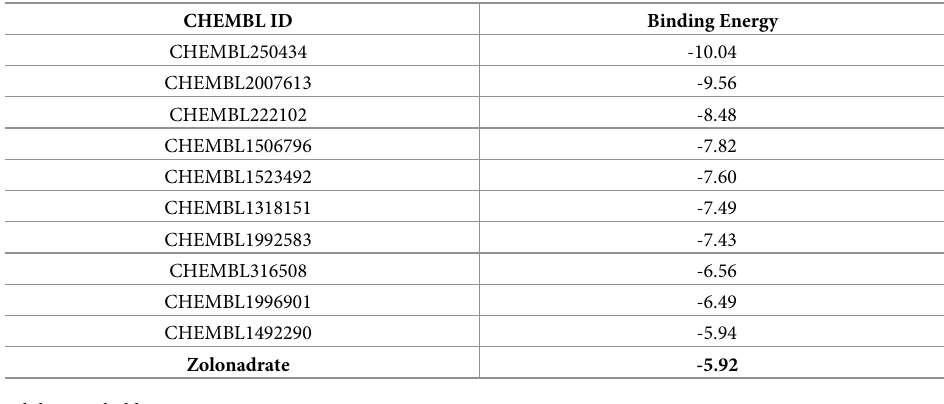
Table 3. Binding energies for top-10 candidates and